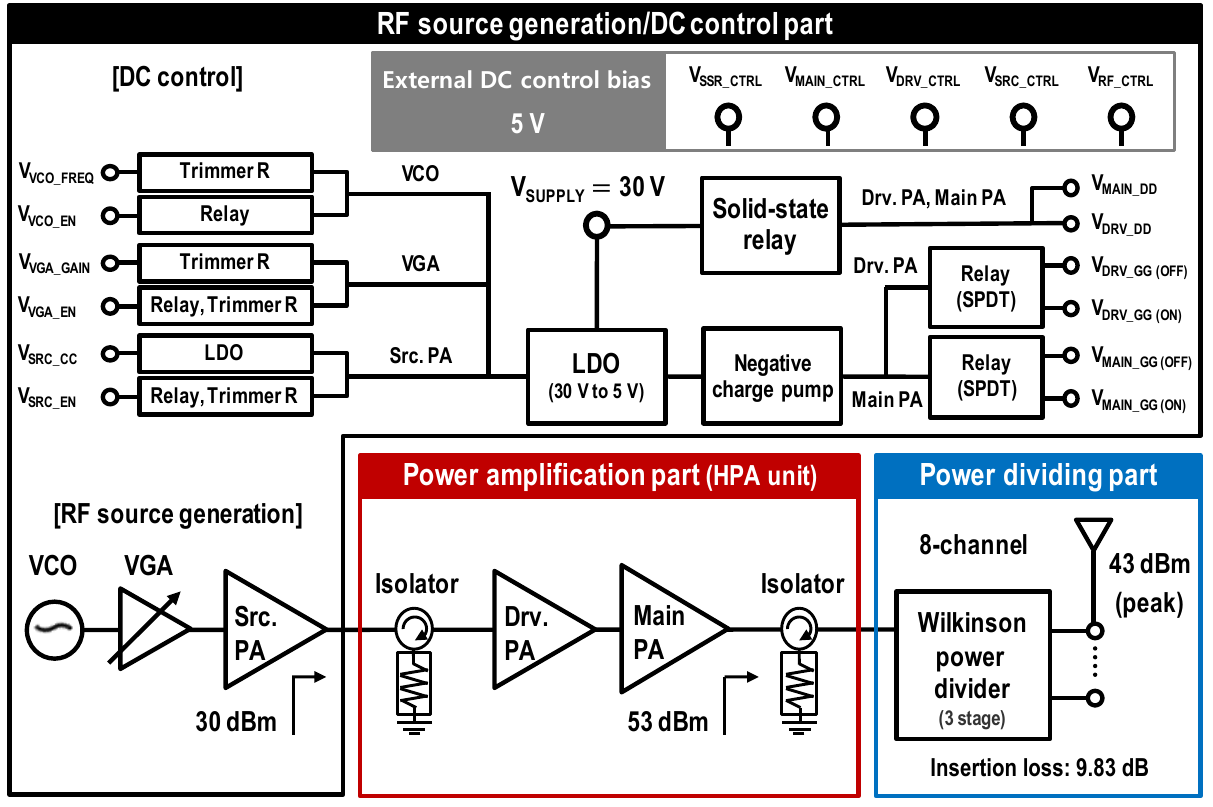
Figure 1. Block diagram of the proposed RF source module.